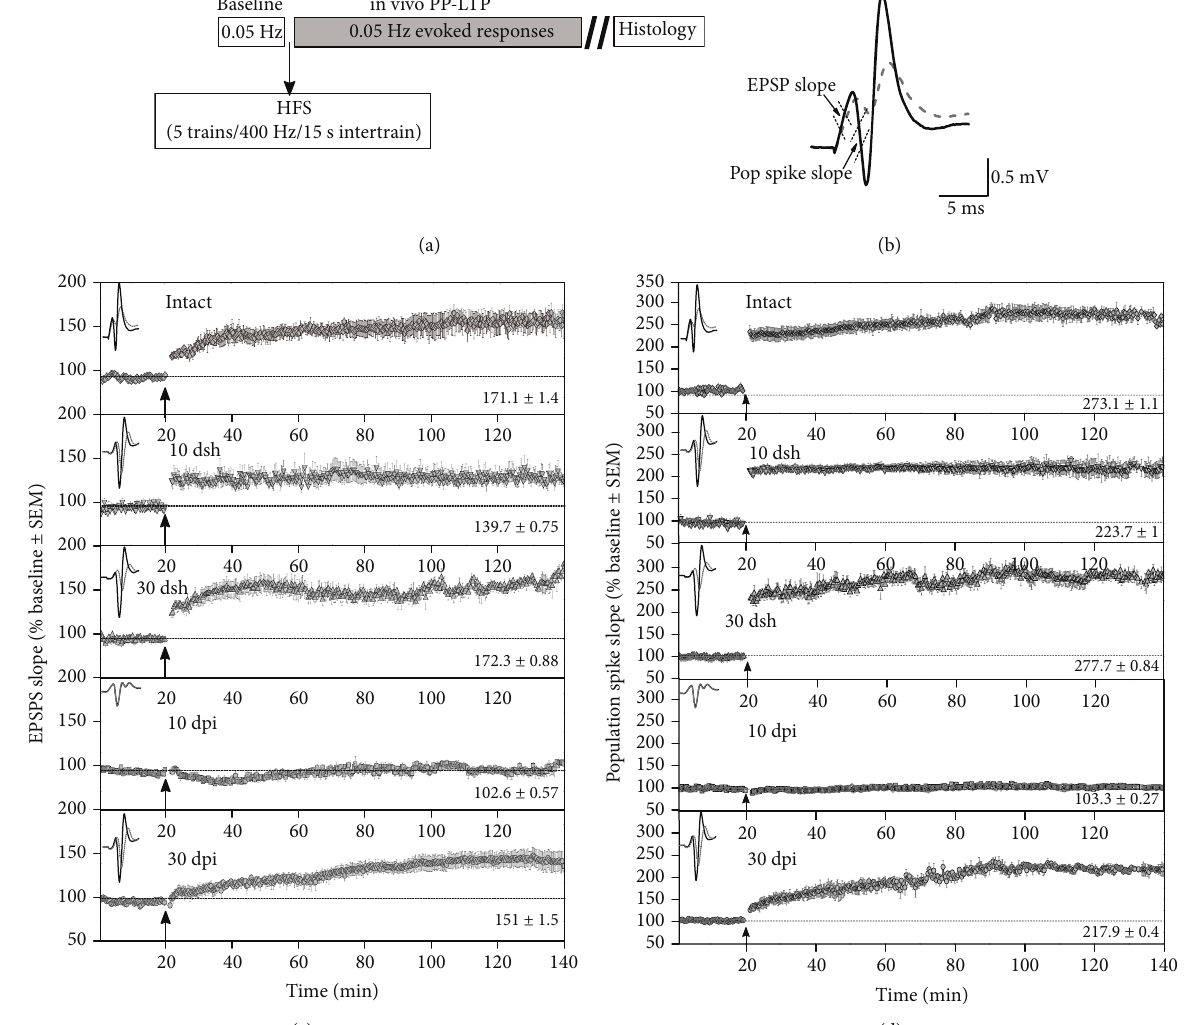
Figure 3: KA-induced alterations in the DG modify in vivo perforant pathway LTP along time. (a) Schematic representation of experimental procedures. Conditioning stimulus trains began after 20min of baseline recording and were maintained for 120min. (b) Representative traces of the excitatory postsynaptic potential (EPSP) obtained during baseline (dotted line) and 140min after stimulation (full line). (c) Plot of the EPSP slope for the last 20min after high-frequency stimulation. Intact and 30 dsh groups displayed similar slope percentages of EPSP (intact 171.1%; 30 dsh 172.3%). The EPSP slope percentage in the 10dsh group was 139.7%, that is, less than those in intact and 30 dsh groups. In the 10dpi group, LTP induction was impaired, as opposed to the 30 dpi group where LTP induction was recovered. Notably, LTP from mice at 30dpi took longer time to reach its maximal response compared to all other groups. All these fi ndings are more evident in the population spike slope percentage. (d) Inner numbers show the mean ± SEM of slope (percent of baseline) from the last 20 min of recording. Application of conditioning stimulus trains is indicated (arrow). Repeated measures ANOVA followed by post hoc Fisher ’ s test; intact n = 4 ; 10 dsh n = 4 ; 30 dsh n = 4 ; 10dpi n = 4 ; 30 dpi n = 4